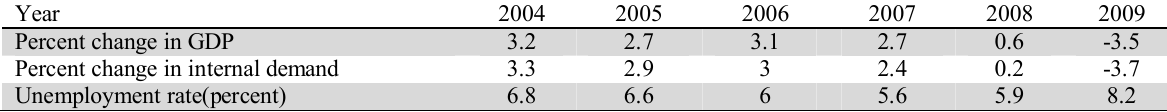
Change in macro Variable in OECD